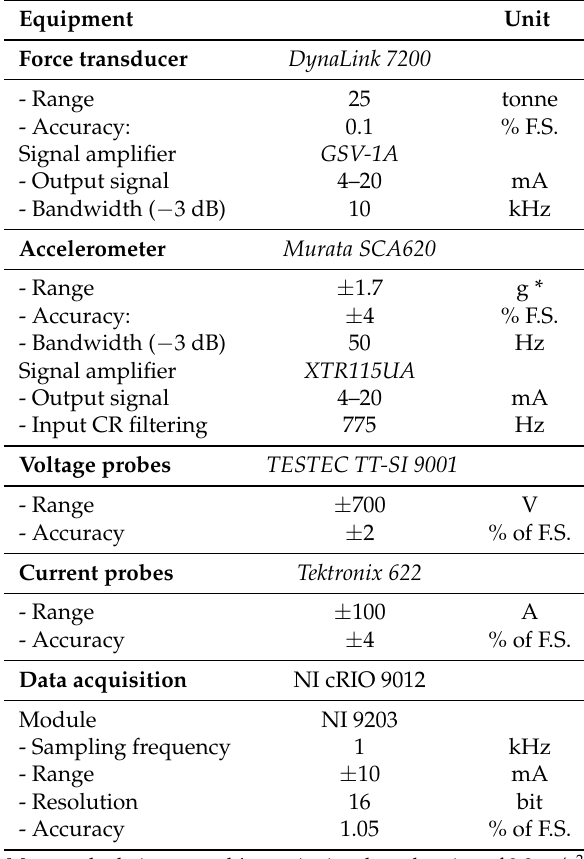
Table 2. Measurement